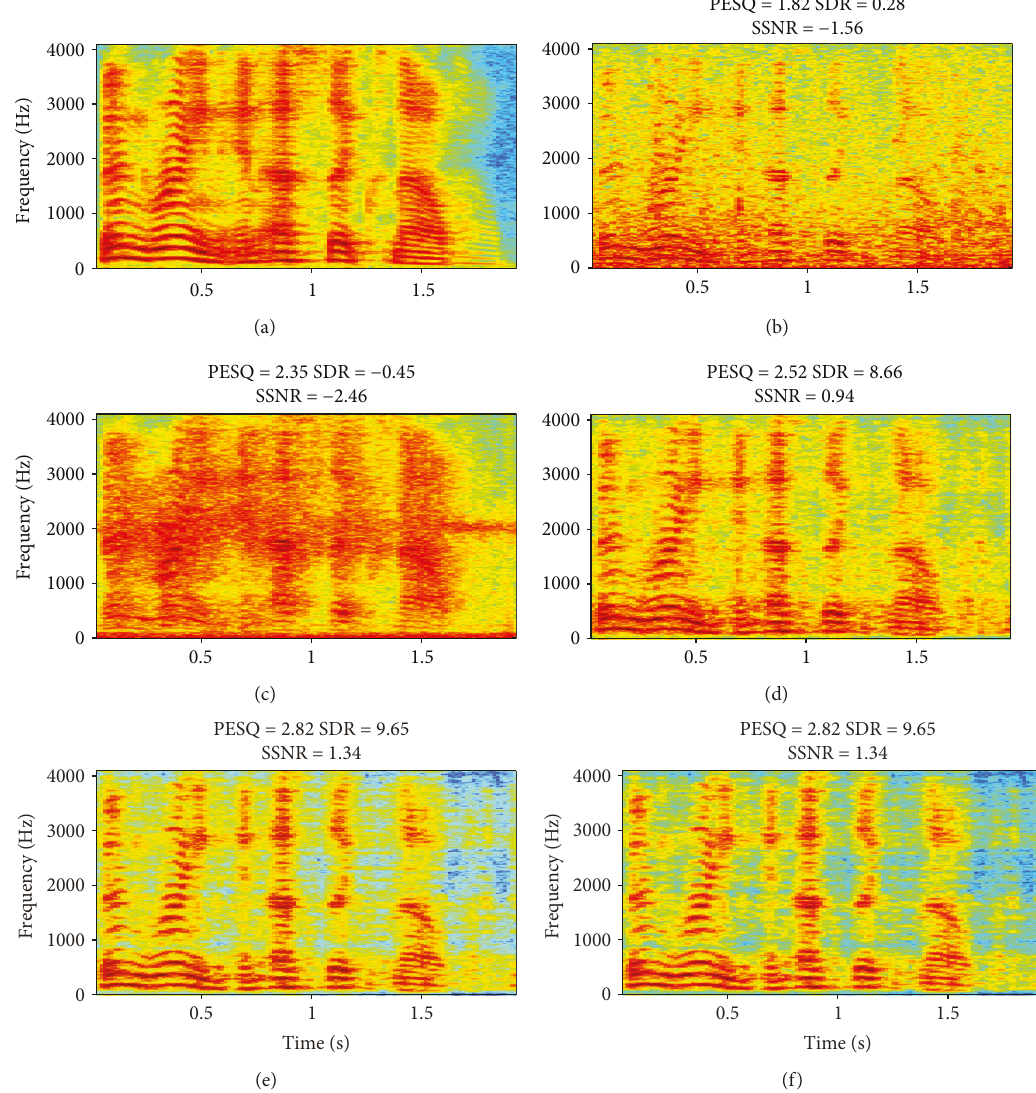
Figure 7: The spectrogram of (a) the clean speech signal, (b) the noisy signal obtained via the delay-and-sum, (c) the noisy speech enhanced by the coherence-based method, (d) the noisy speech enhanced by the standard NMF, (e) the noisy speech enhanced by the proposed method ( β = 2 ), and (f) the noisy speech enhanced by the proposed method ( β = 1